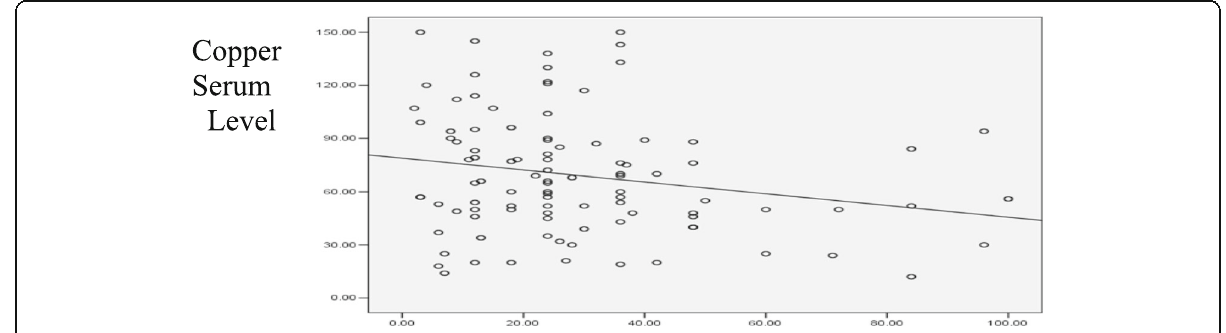
Fig. 3 Correlation coefficient showed negative correlation between copper serum level and duration of illness in